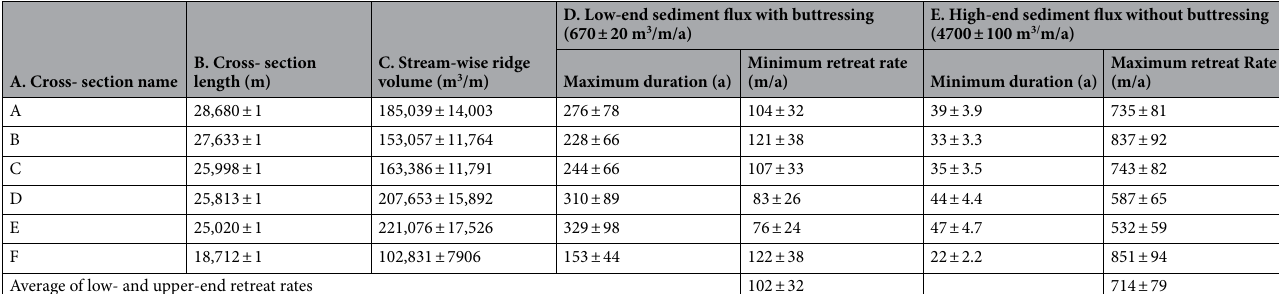
Table 1. Stream-wise volume of sediment ridges from cross section data plus the corresponding duration and retreat rates from two end-member sediment flux estimates. (A) Cross section name; (B) Cross section length; (C) Stream-wise ridge volume; (D. Low-end sediment flux with ice-shelf buttressing and the inferred maximum duration and minimum retreat rate and (E) High-end sediment flux without ice-shelf buttressing and the inferred minimum duration and maximum retreat rate. The bottom row of columns D and E show the uncertainty for the low- and upper-end retreat rates averaged for cross sections A through